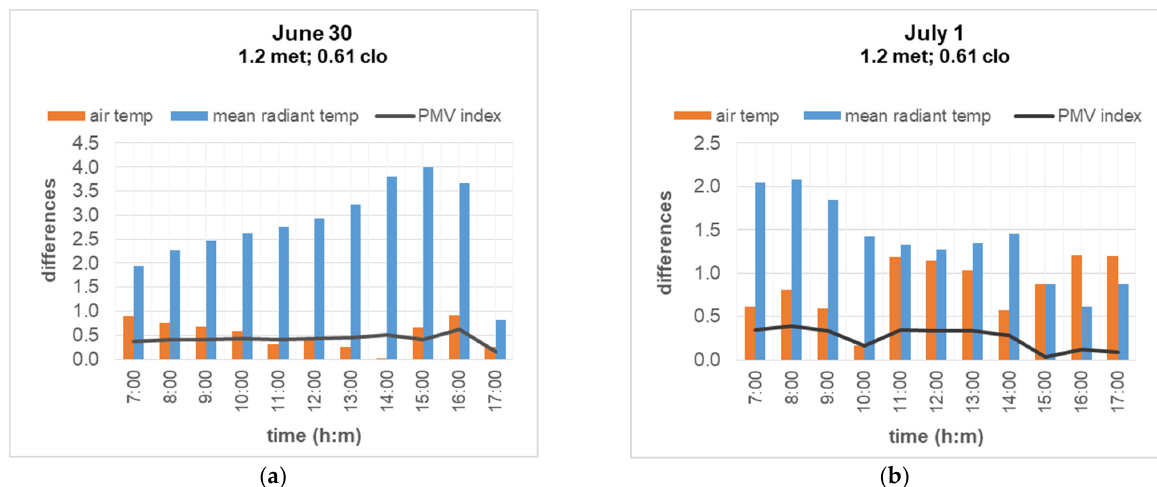
Figure 18. Comparison of PPD indices and temperature differences between measurement and simulation: ( a ) for 30 June, ( b ) for 1 July. Table 4. Summary table of statistical analysis of differences between measurement and simulation .